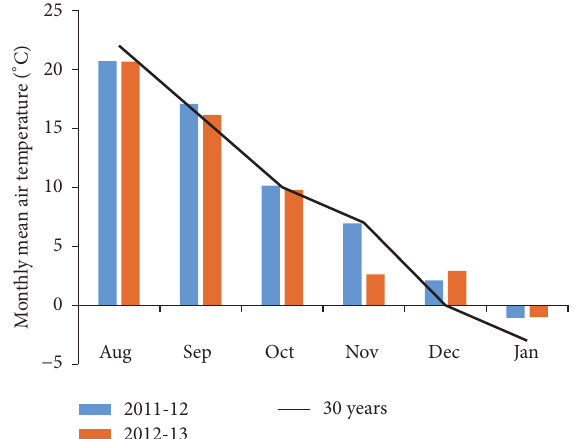
Figure 2: Monthly mean air temperature and 30-year mean values at Reedsville, WV.